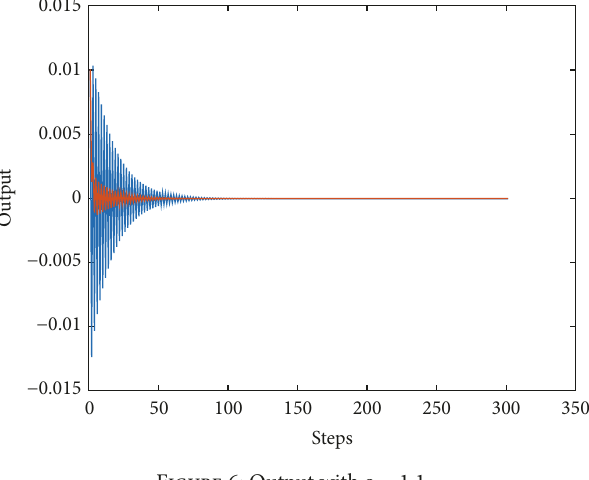
Figure 6: Output with 𝜀 = 1.1